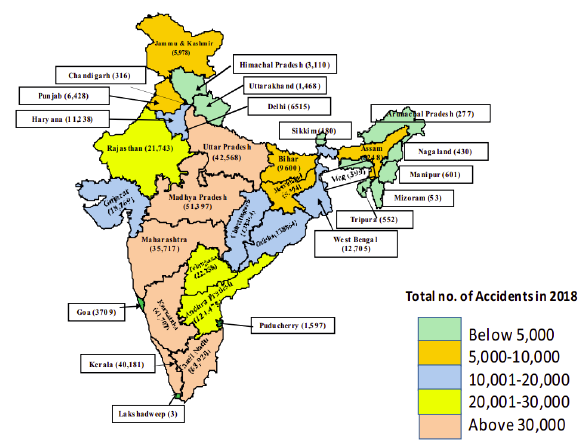
Figure 1. Road Accident in 2018-State wise[7]